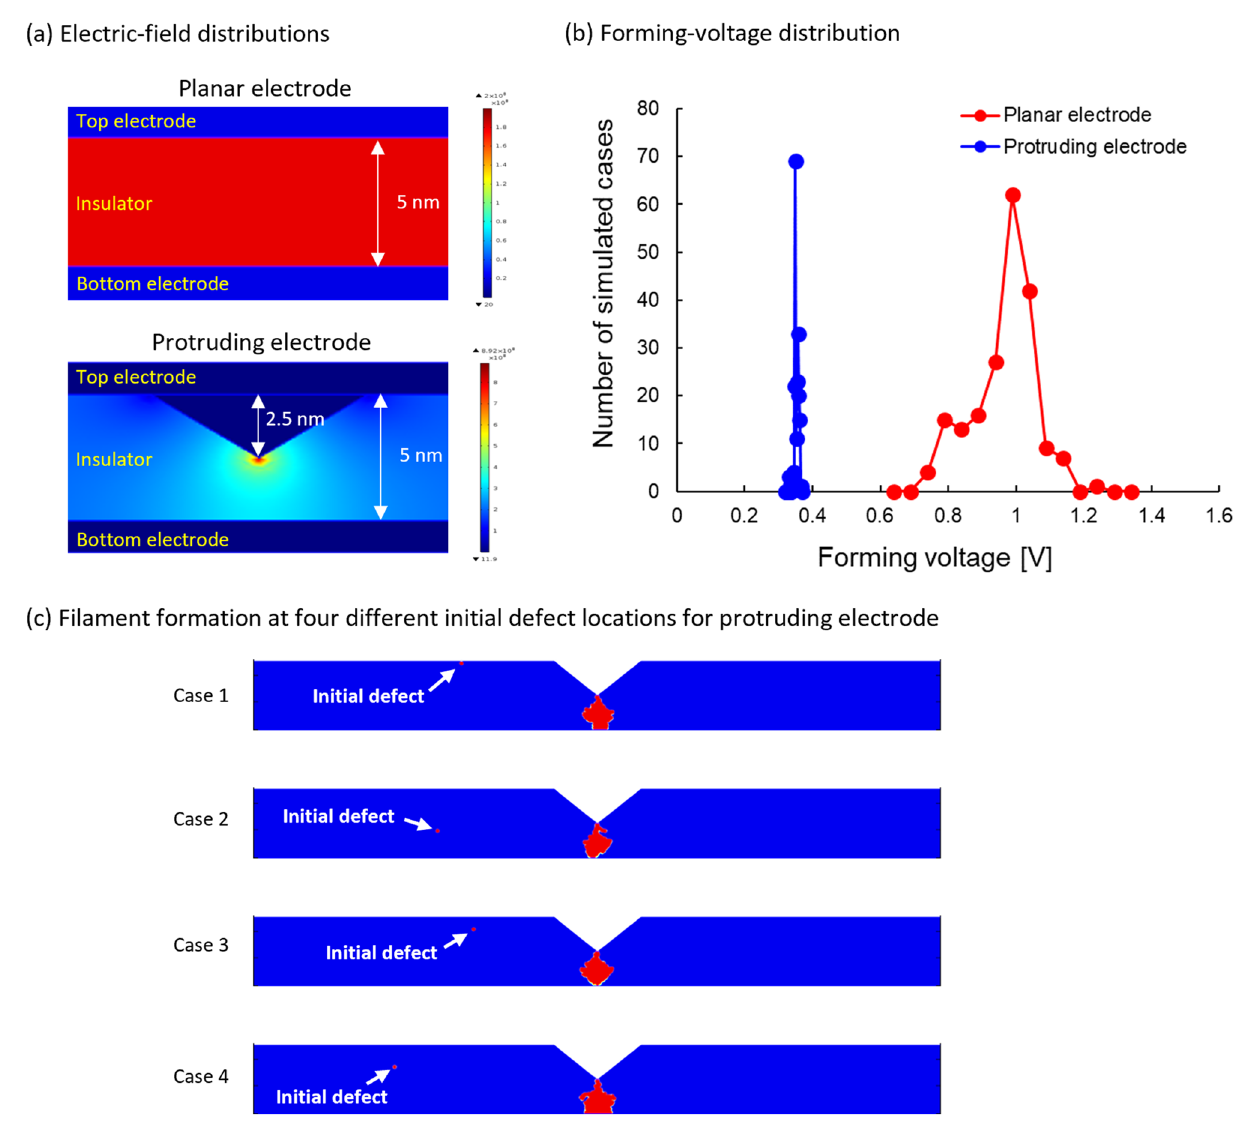
Figure 9. Comparison of switching uniformity between planar and protruding electrodes. ( a ) Electric field distributions of planar and protruding electrodes, ( b ) forming-voltage distributions, and ( c ) conductive filaments for four different initial defect locations for protruding electrode. In ( c ), only insulator parts are shown. The defect formation of energy of 4.5 eV was